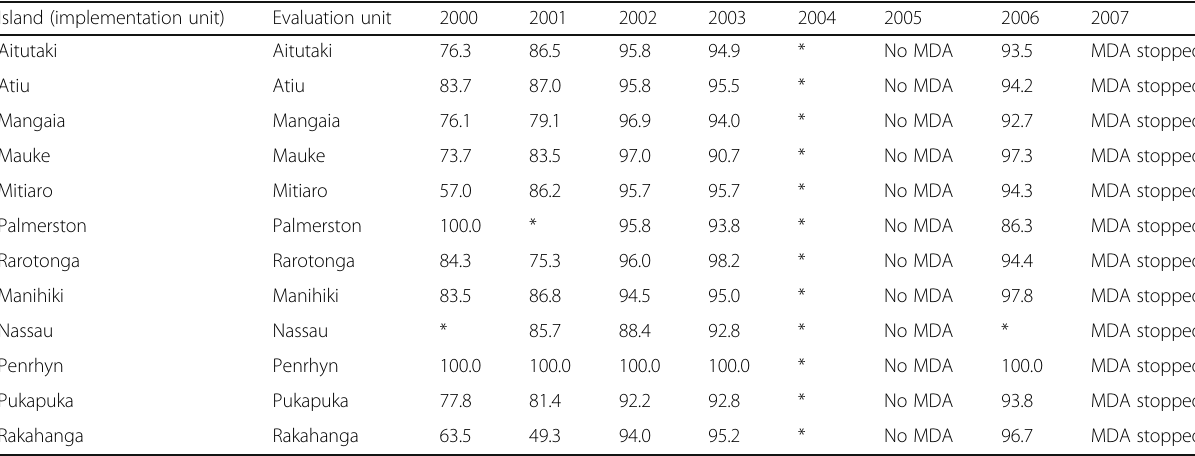
Table 3 Treatment coverage of eligible population (i.e., > 2 years old) in different MDA implementation units of the Cook Islands Island (implementation